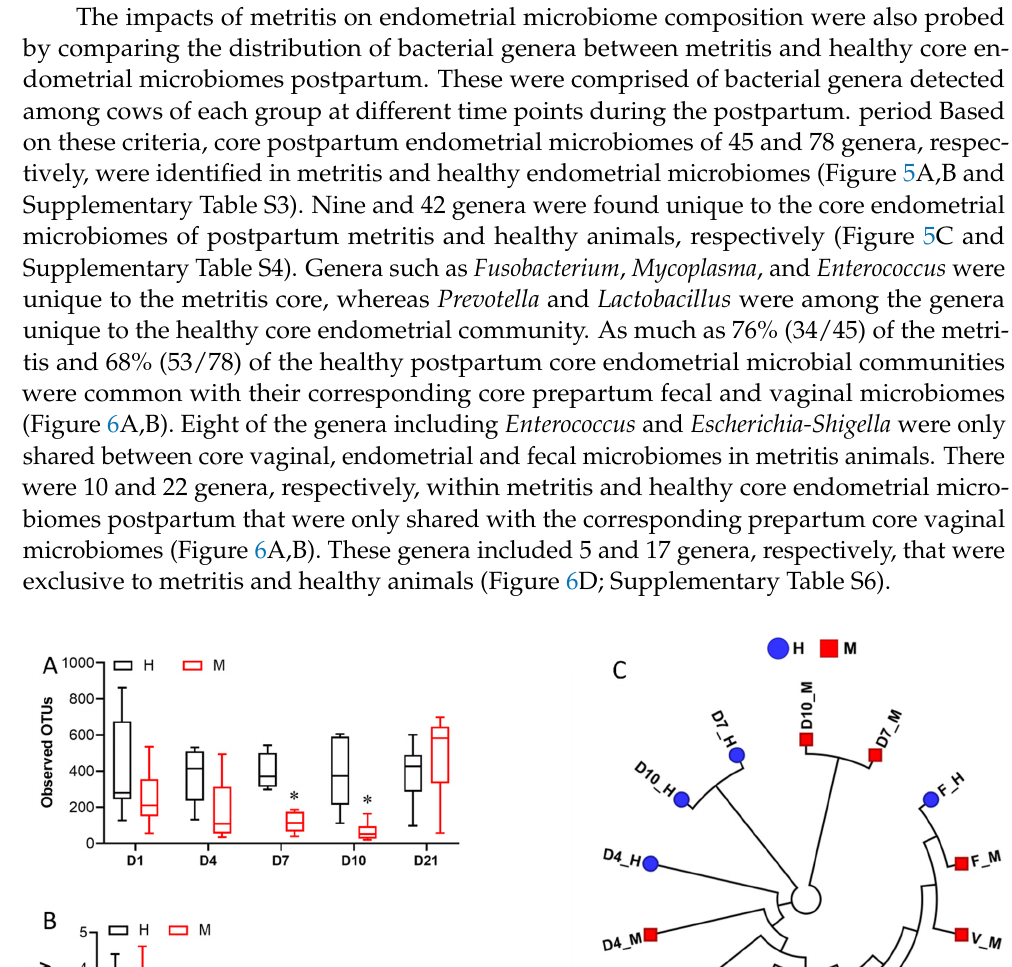
Figure 4. Comparison of the taxonomic composition of postpartum uterine microbiomes between healthy (H) and metritis (M) animals. ( A ) NMDS plots based on Bray-Curtis dissimilarity distances between postpartum uterine microbiomes of individual cows for each time point. Individual points represent single cows ( T = 10 for each group). Blue—healthy cows; Red—metritis cows. Bar graphs showing averaged relative abundances and distribution for the top 5 phyla ( B ) and top 10 genera ( C ). Unclassified genera are denoted by NA. Relative abundances were rescaled to account for only the 5 (phyla) and 10 (genera) most abundant phyla.